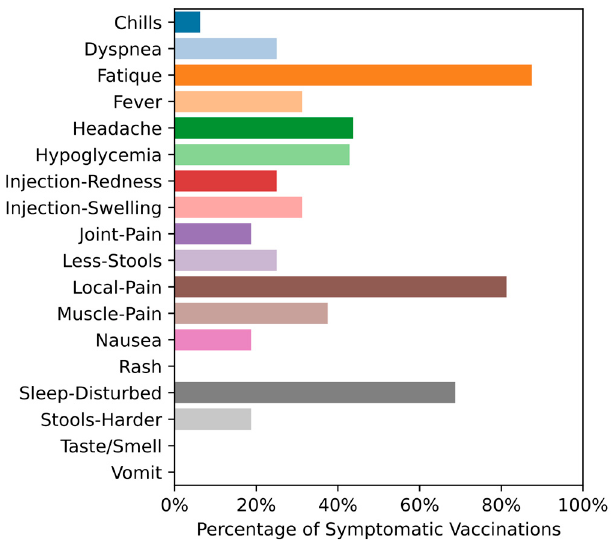
Figure 5. Symptom frequency purely based on whether the patients had the specific symptom during the two vaccination phases.